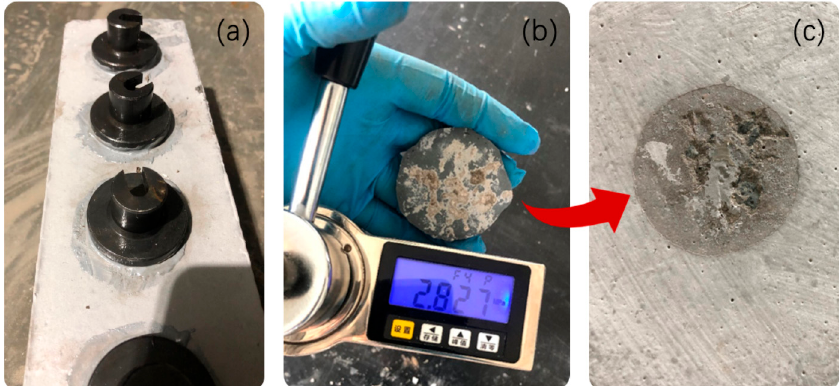
Figure 4. Adhesive strength test of GPC: ( a ) standard steel flanges glued on the surface of GPC layer that was previously coated on concrete substrate; ( b ) pulling out steel flanges from glued GPC surface with a portable adhesion tester, the LCD screen displays adhesive strength (MPa) of GPC; ( c ) failure interface between GPC layer and concrete substrate.